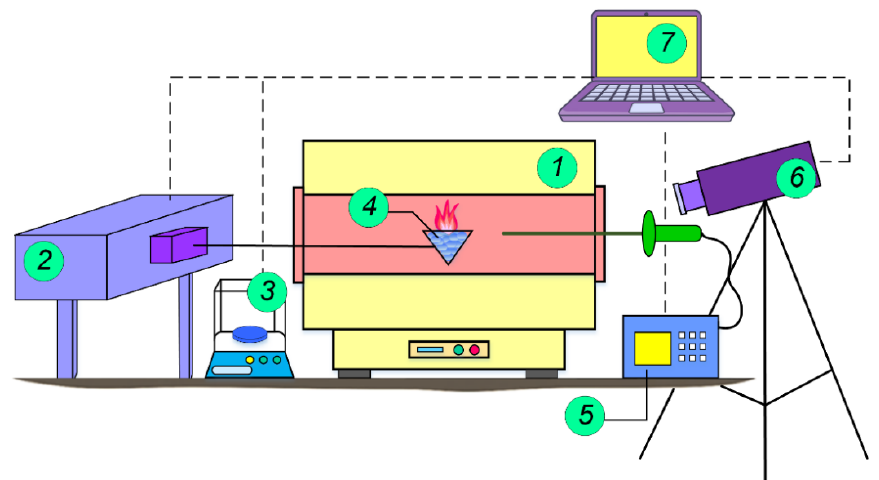
Figure 1. Scheme of the setup for studying the fuel ignition behavior on radiative heating: 1—muffle furnace; 2—positioning mechanism; 3—electronic balance; 4—metal holder with a fuel sample; 5—gas analyzer; 6—high-speed video camera; 7—laptop.